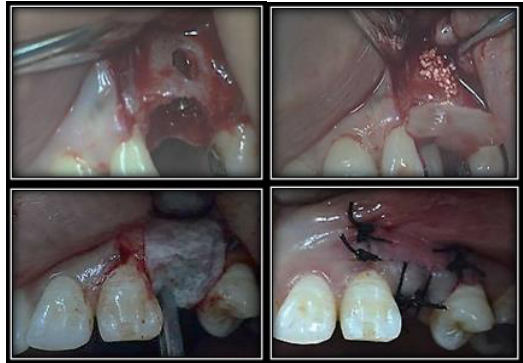
Figure 6: Bone defects repaired by β-TCP and collagen